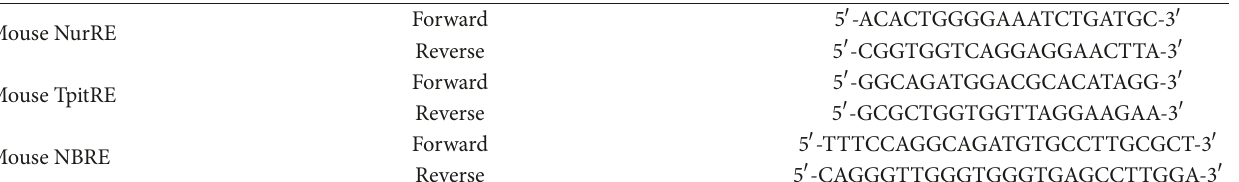
Table 2: Primer sequences for ChIP-qPCR.